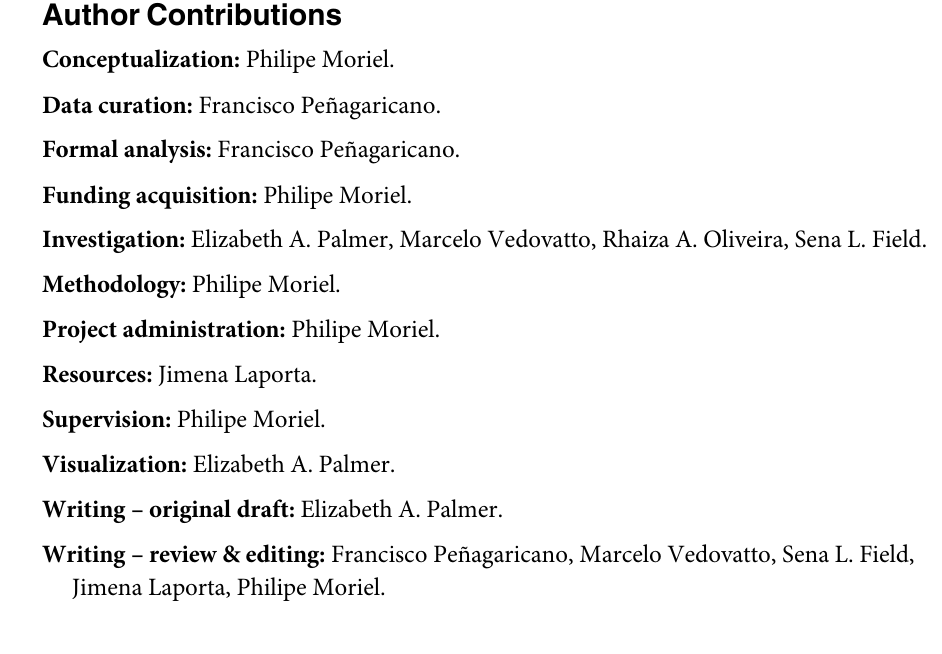
S3 Table. List of Gene Ontology (GO) terms significantly enriched with differentially expressed genes. Significant GO terms with the up and downregulated genes enriched in each term for the effect of maternal supplementation with protein and energy ( P � 0.025), maternal supplementation with methionine ( P � 0.05) and time (FDR � 0.0001) in the longissimus dorsi muscle of early-weaned Bos indicus -influenced